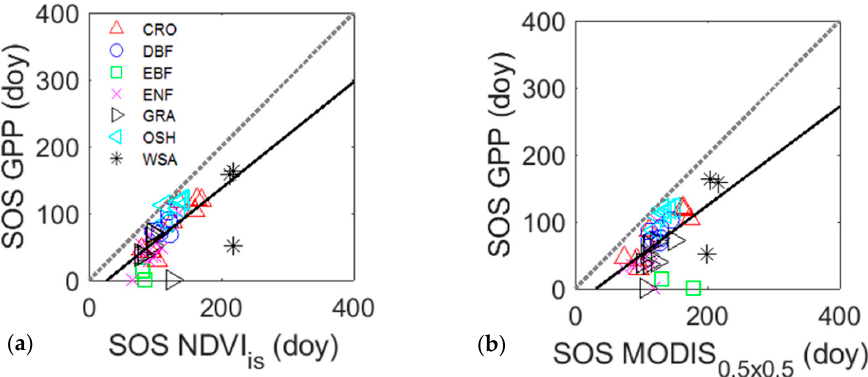
Figure 5. Relationship between the start of season (SOS) derived from GPP eddy covariance data (in days) for di ff erent biomes and data derived from ( a ) NDVI is and ( b ) NDVI MD at a spatial resolution of 0.5 × 0.5 km. ENF: Evergreen needle leaf forest; EBF: Evergreen broadleaf forest; DBF: Deciduous broadleaf forest; GRA: Grassland; CRO: Cropland; WSA: Woody Savanna; and OSH: Open